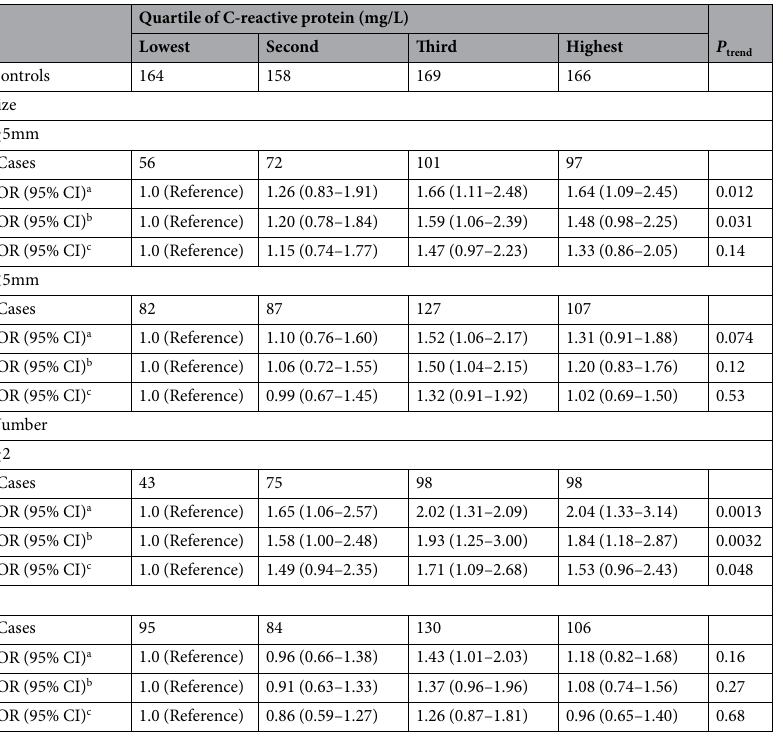
Table 4. Association of C-reactive protein with colorectal adenoma by size and number. a Adjusted for age (40– 49, 50–54, 55–59, 60–64, ≥ 65 years), sex, and screening period. b Further adjusted for family colorectal cancer history, pack-years of smoking (never, ≤ 20, 21–40, > 40 pack-years), alcohol drinking (never, past, < 150, 150– 299, ≥ 300 g per week), physical activity (METs-hour/day, quartile), and history of diabetes mellitus. c Further adjusted for body mass index (BMI) ( < 21.0, 21.0–22.9, 23.0–24.9, and ≥ 25.0 kg/m 2